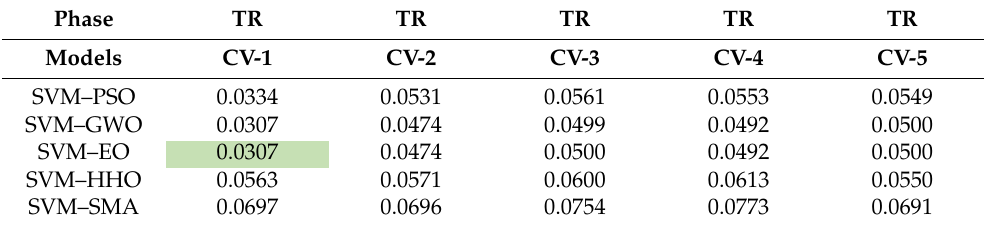
Table 4. Performance of five-fold cross-validation (training phase).